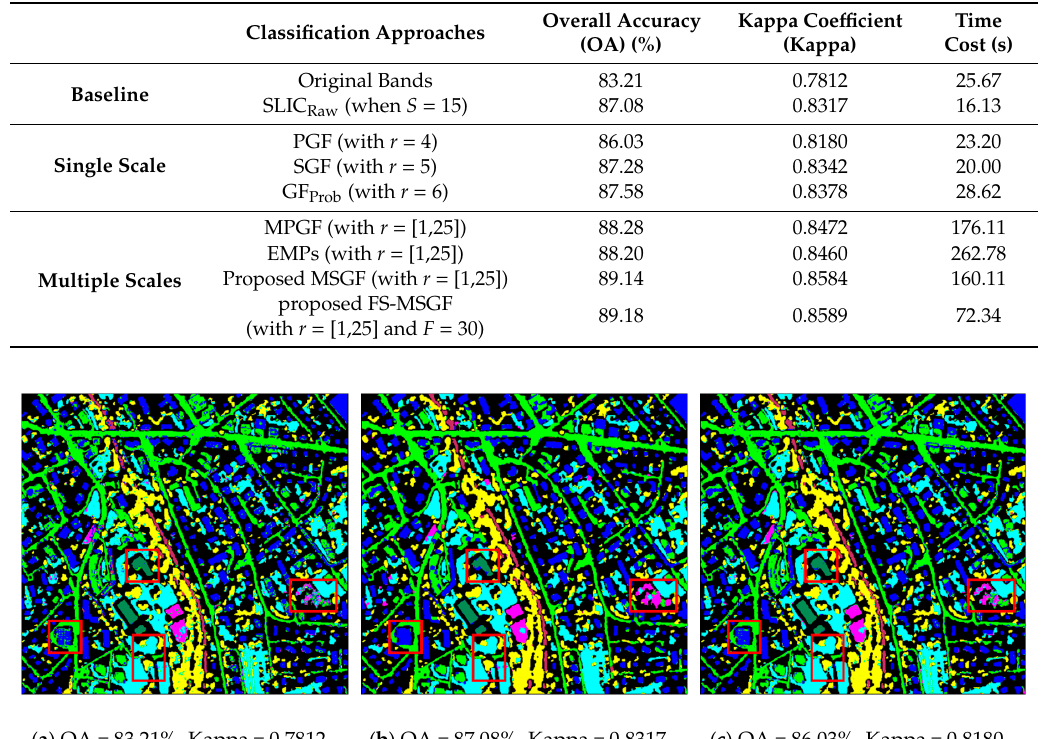
Table 2. Classification results of Zh1 obtained by the proposed and reference methods.